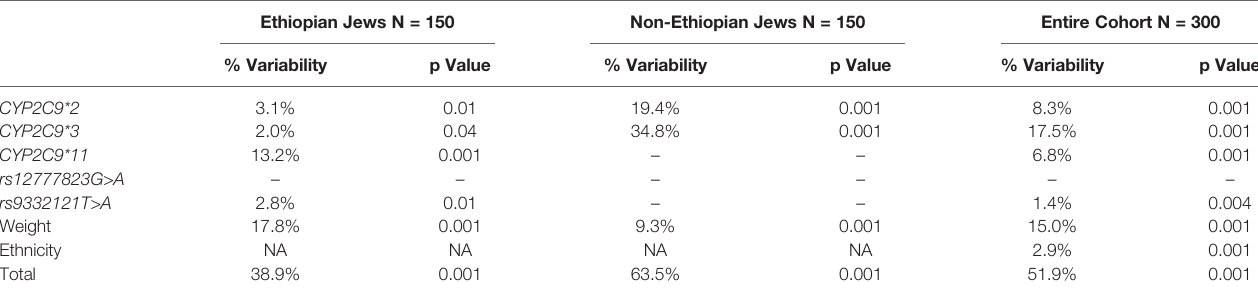
TABLE 7 | Multiple regression model for the prediction of Log 10 PMR24/12 among Ethiopian Jews, non-Ethiopian Jews, and the entire cohort of both Ethiopian and non-Ethiopian Jews. Ethiopian Jews N = 150 Non-Ethiopian Jews N =